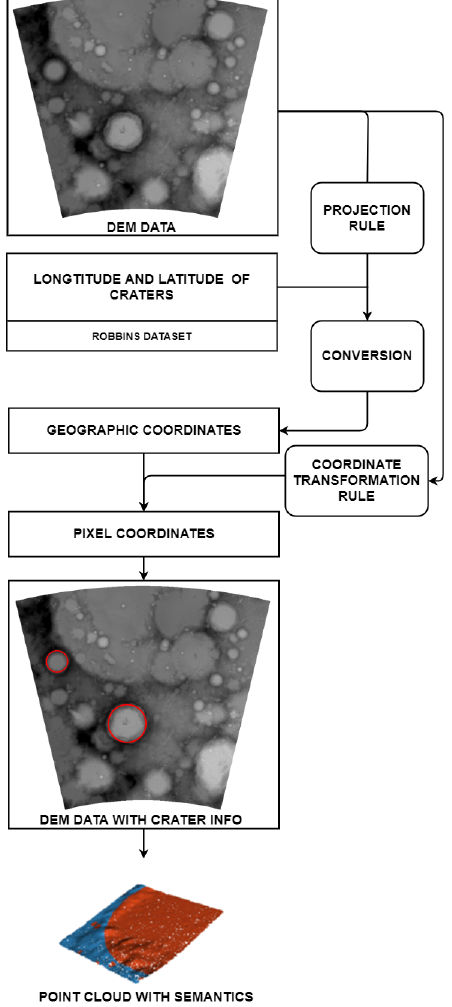
Figure 2. The construction process of the point cloud dataset. The projection rule is capable of completing the mapping from longitude and latitude to geographical coordinates, and the coordinate transformation rule leads to the conversion from geographic coordinates to pixel coordinates.